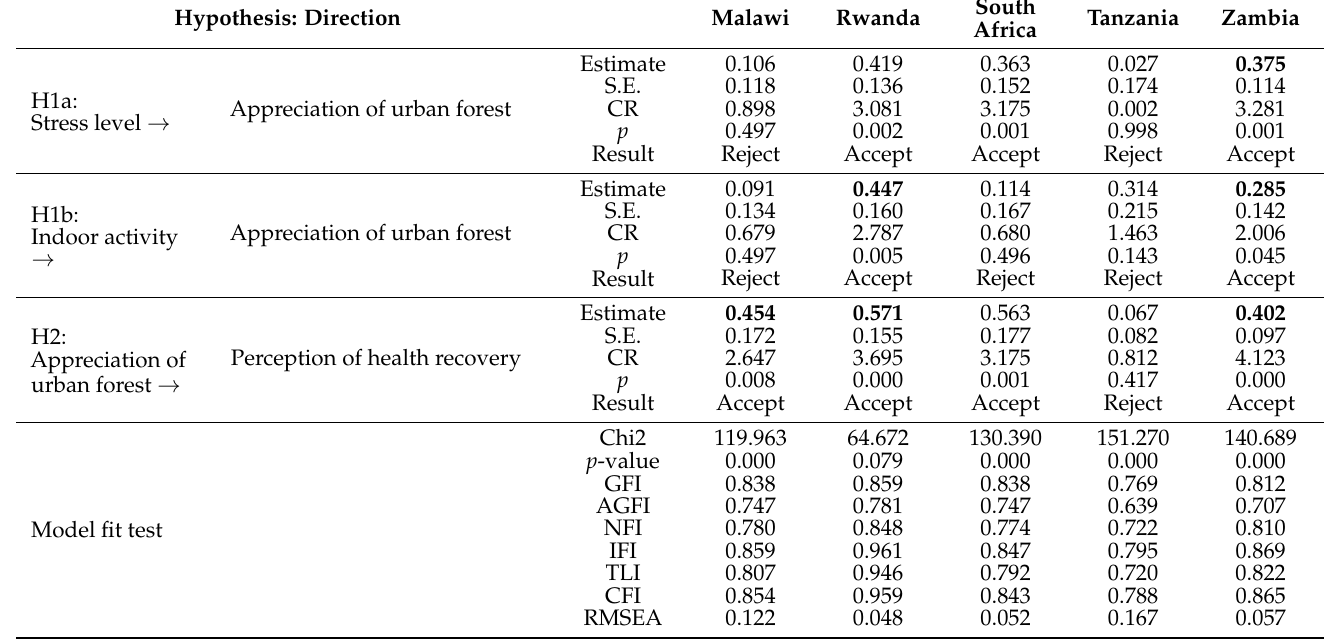
Table A1. Research hypotheses tested by SEM model